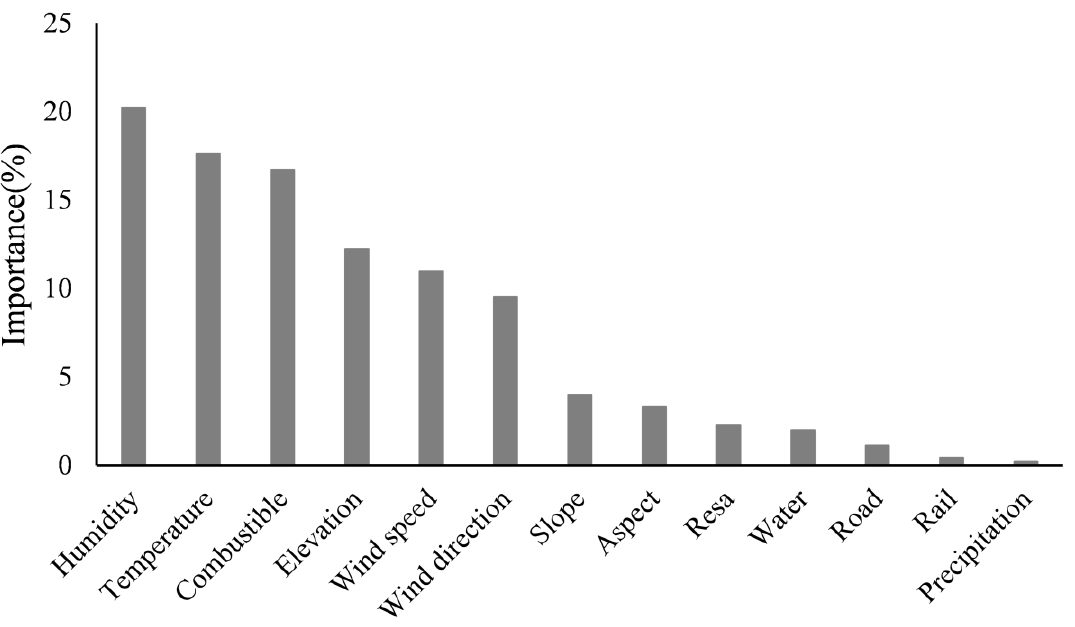
Figure 8. The random forest algorithm ranking of the importance of the 13 analyzed variables.